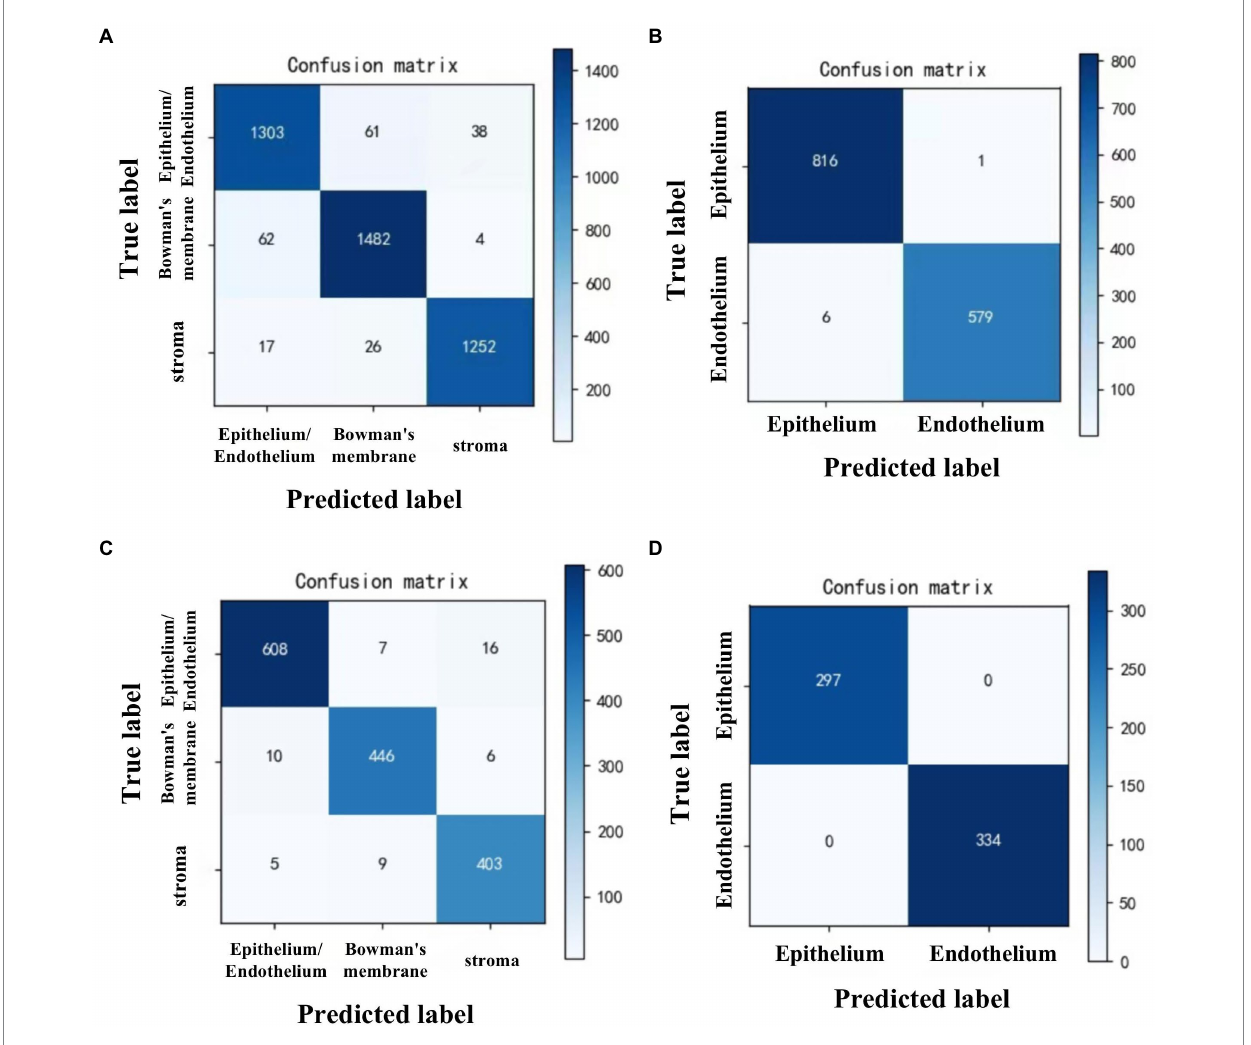
FIGURE 3 Confusion matrix diagrams of 2 DCNN models in internal and external test datasets. DCNN1: classifying all images to epithelium/endothelium, bowman’s membrane, and stroma classes. DCNN2: distinguish the epithelial and endothelial images. (A) DCNN1 in internal test dataset. (B) DCNN2